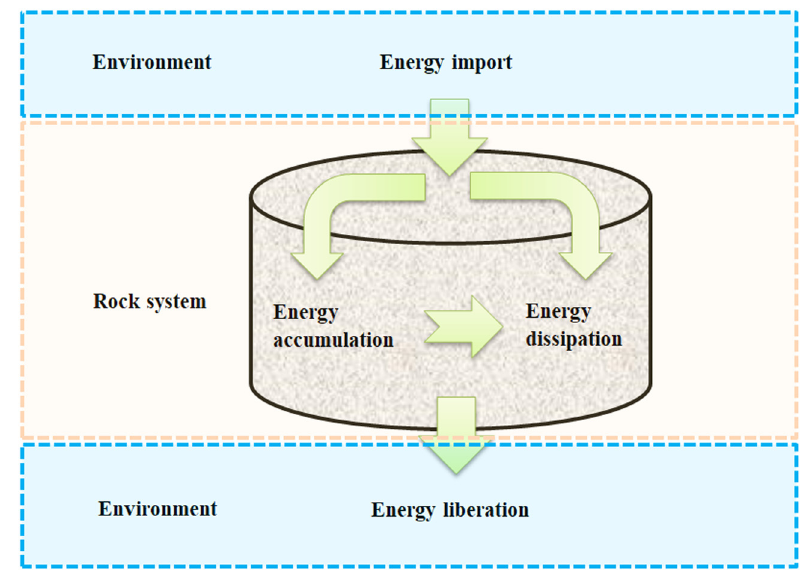
Figure 3: Four main forms of energy transfer and transformation during rock impact failure.